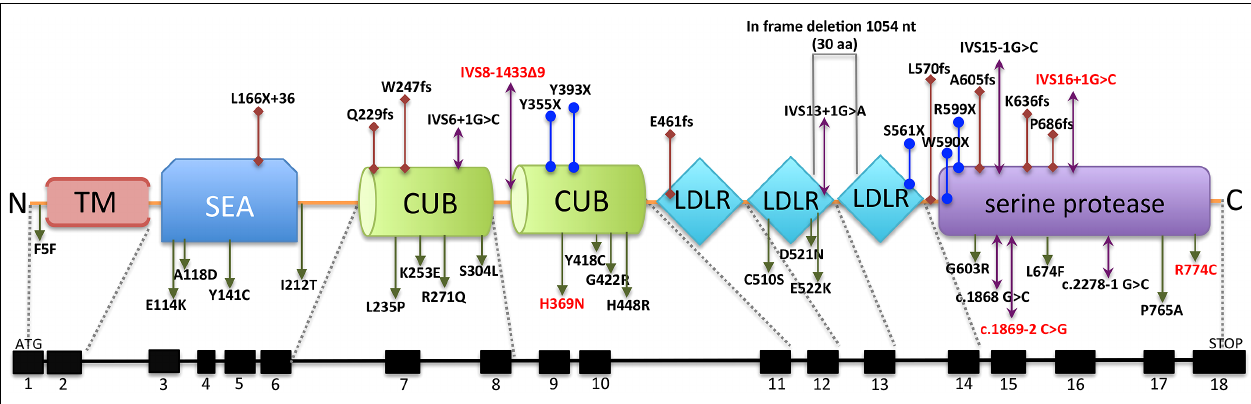
FIGURE 1 | TMPRSS6 gene structure and schematic representation of corresponding matriptase-2 mutations reported in IRIDA patients. The genomic organization and the corresponding structural domains of matriptase-2 with currently identified mutations are shown.The missense,